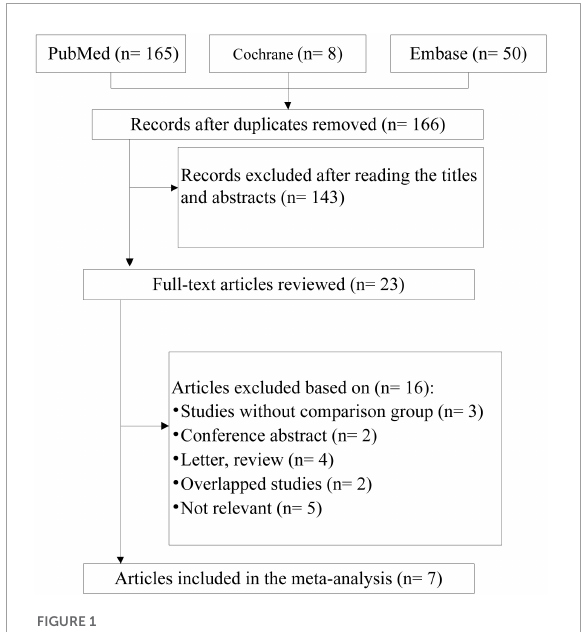
FIGURE1 Flow chart of the studies considered and finally selected for